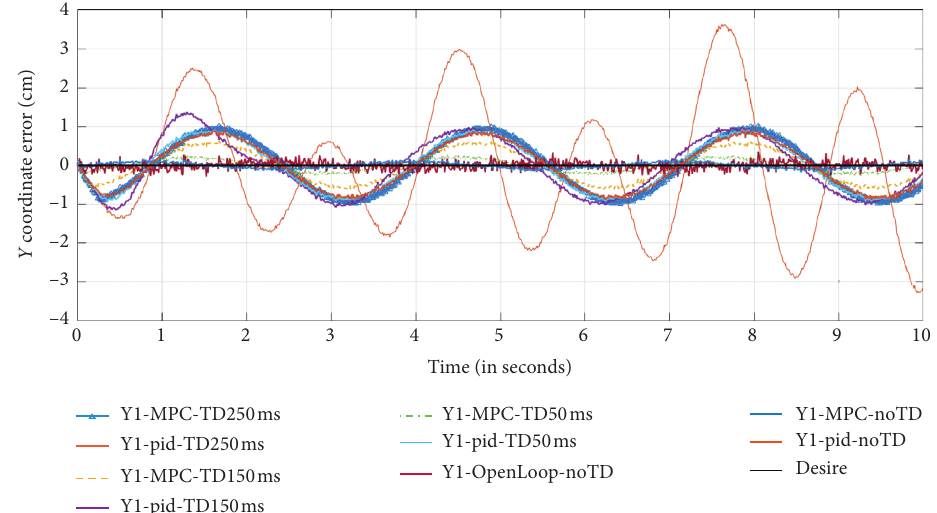
Figure 10: The performance of the coordinate difference in the Y -axis direction of the block. The TD will cause the regular periodic error of the sine